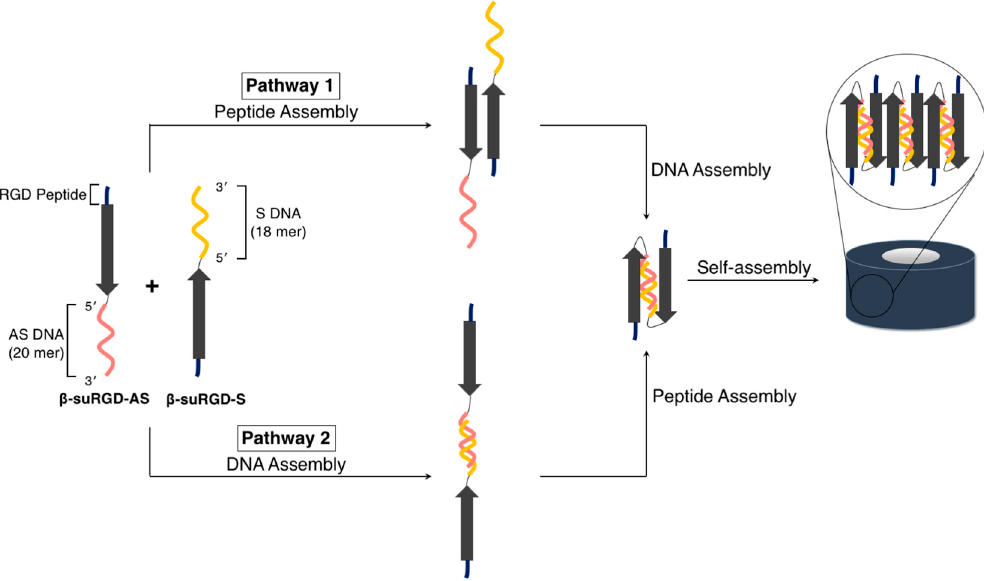
Figure 12. Sequences of the two DNA / peptide hybrids, β -suRGD-AS and β -suRGD-S , and the two distinct protocols that controlled their assembly pathway to yield the monodispersed toroidal nanostructures ( β -suRGD-AS / β -suRGD-S ). Adapted from [104]. Copyright 2016 John Wiley and